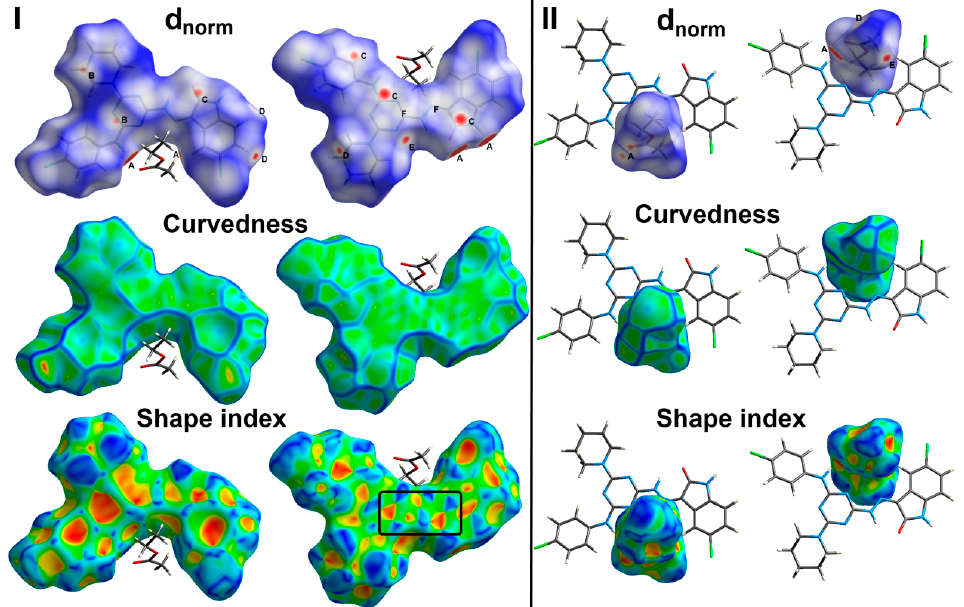
Figure 4. Hirshfeld surfaces for the target molecule ( I ) and the crystal solvent ( II ) showing the most significant contacts; A, B, C, D, E and F refer to the short O…H, C…H, C…C, H…H, N…H and C…N interactions, respectively.